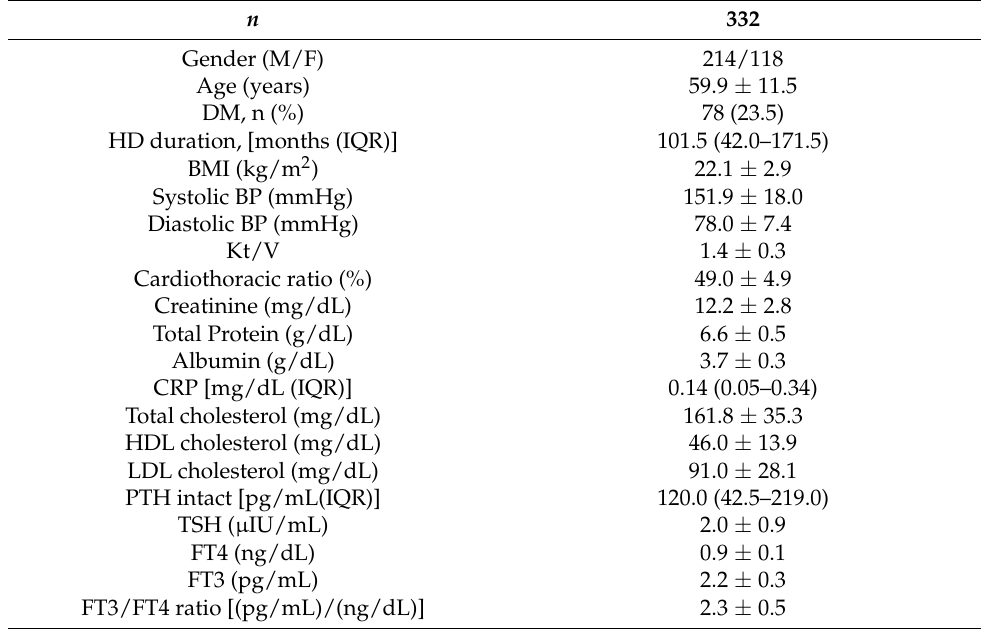
Table 1. Baseline clinical characteristics of 332 euthyroid hemodialysis